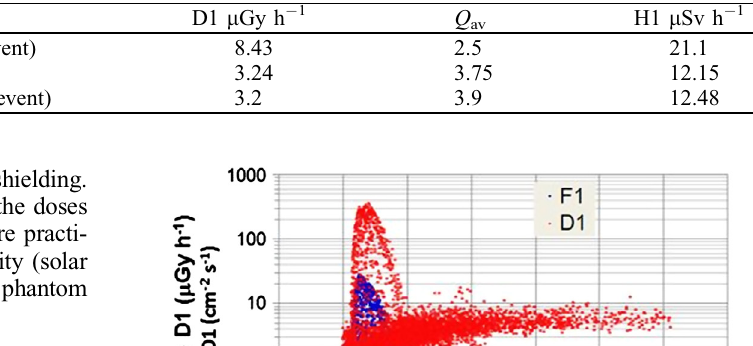
Table 2. Time intervals, averaged dose rates, quality factors , and dose equivalent rates at 40 mm depth in the phantom obtained outside the SAA during the March 07 and the May 17 SEP events (two upper rows), and during quiet radiation conditions before May 17 SEP event.